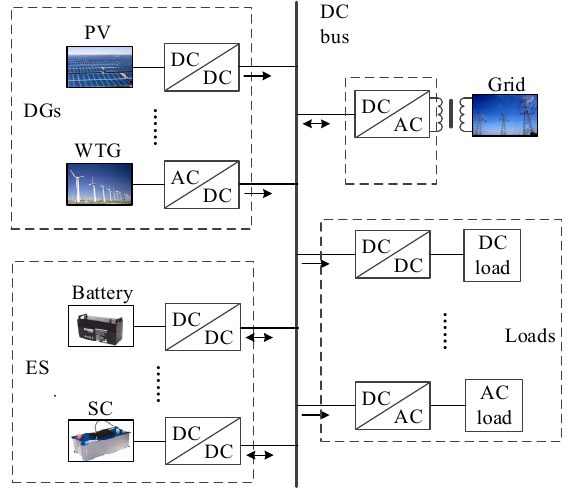
Figure 1. Typical structure diagram of DC microgrid system.